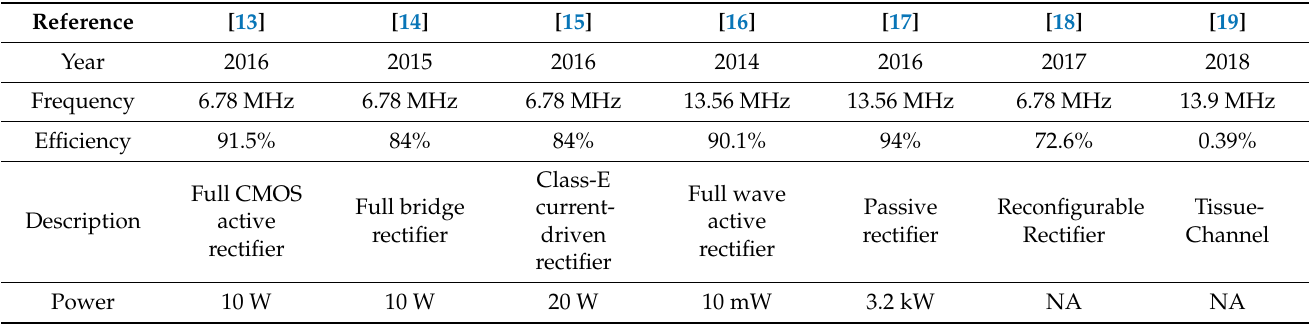
Table 2. Comparison of recent prior